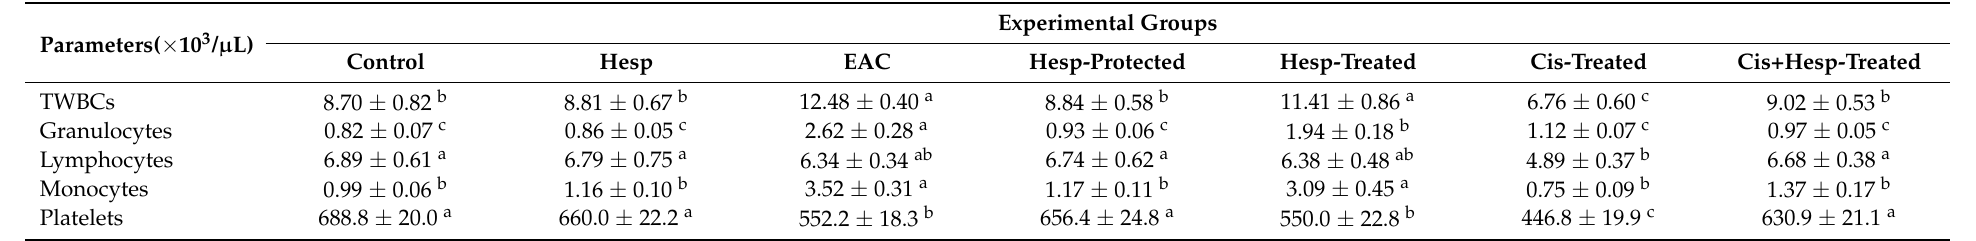
Table 3. Effect of hesperidin and/or cisplatin on leukogram and blood platelets of EAC-bearing